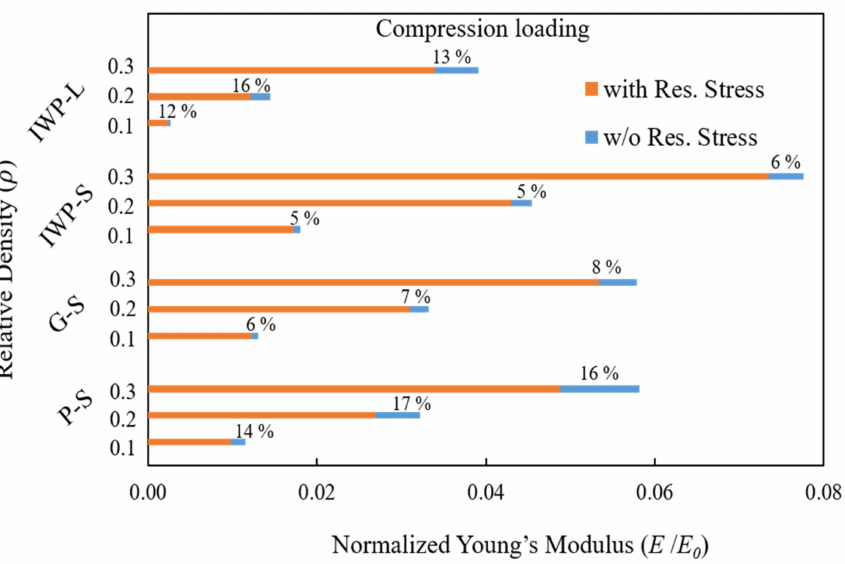
Figure 17. The reduction in Young’s modulus in percentages for compressive loading for all TPMSs and their relative